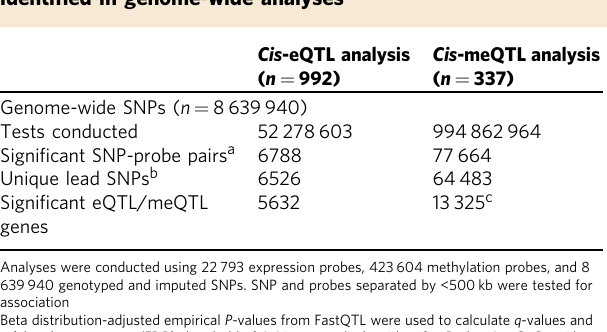
Table 1 Summary of cis -eQTL and cis -meQTL signals identi fi ed in genome-wide